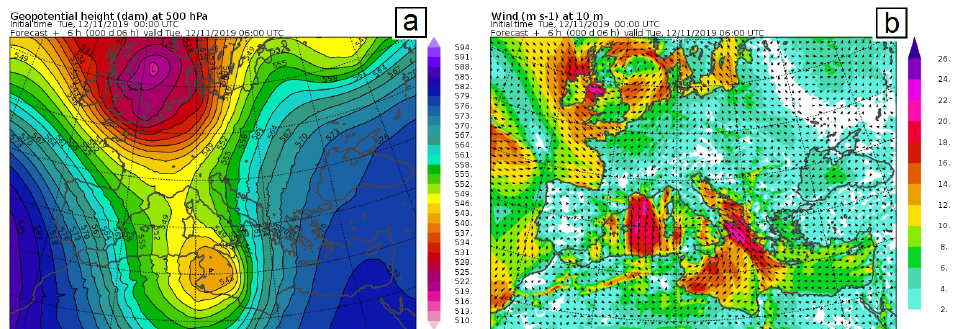
Figure 12. 12 November 2019 06:00 UTC: ( a ) Geopotential height (dam) at 500 hPa; ( b ) Wind (m/s) at 10 m (Bolam